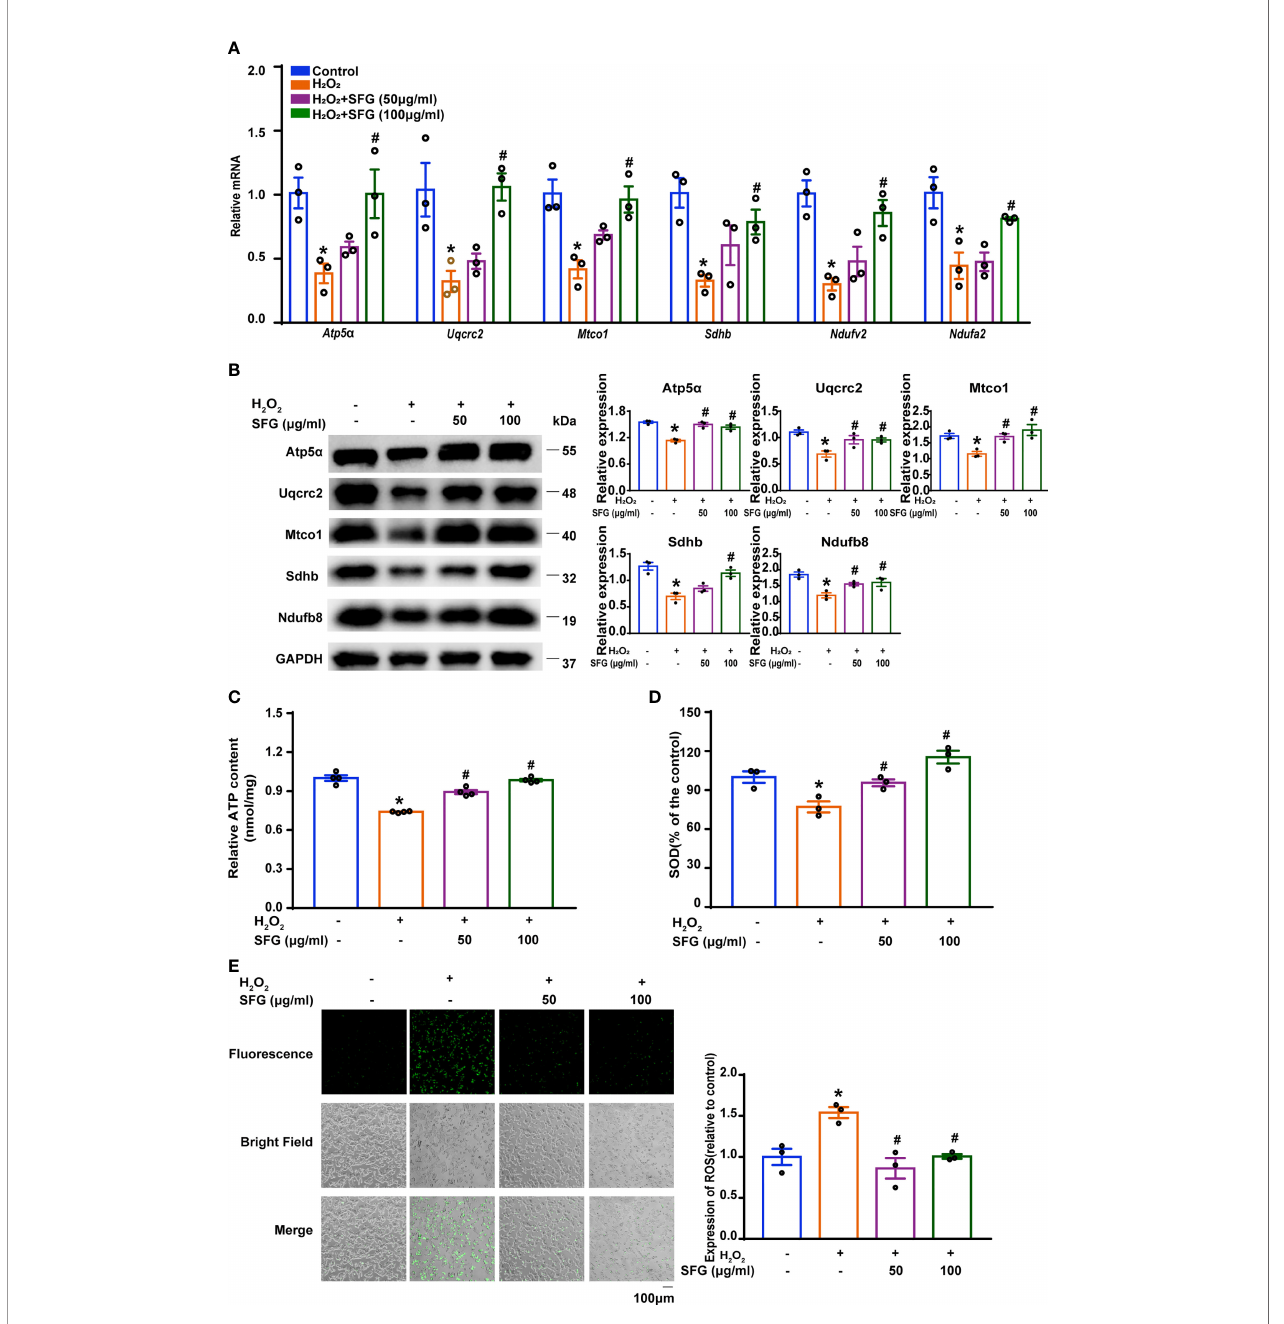
FIGURE 5 | SFG alleviated mitochondrial dysfunction and decreased ROS generation in H 2 O 2 -treated MIN6 cells. (A) Gene expression of Sdhb , Mtco1 , Uqcrc2 , Atp5a , Ndufv2 , and Ndufa2 in MIN6 cells (n=3). *P < 0.05 versus control; # P < 0.05 versus H 2 O 2 -only group. (B) Western blot analysis of the expression of Atp5 a , Uqcrc2, Mtco1, SDHB, Ndufb8 in MIN6 cells (n=3). GAPDH was used as a loading control. Densitometric analysis of the Western blot bands were shown. *P < 0.05 versus control; # P < 0.05 versus H 2 O 2 -only group. (C) ATP content in MIN6 cells (n=3). *P < 0.05 versus control; # P < 0.05 versus H 2 O 2 -only group. (D) SOD levels in MIN6 cells (n=3). *P < 0.05 versus control; # P < 0.05 versus H 2 O 2 -only group. (E) ROS levels in MIN6 cells (n=3). Quantitative analysis of ROS was shown. *P < 0.05 versus control; # P < 0.05 versus H 2 O 2 -only